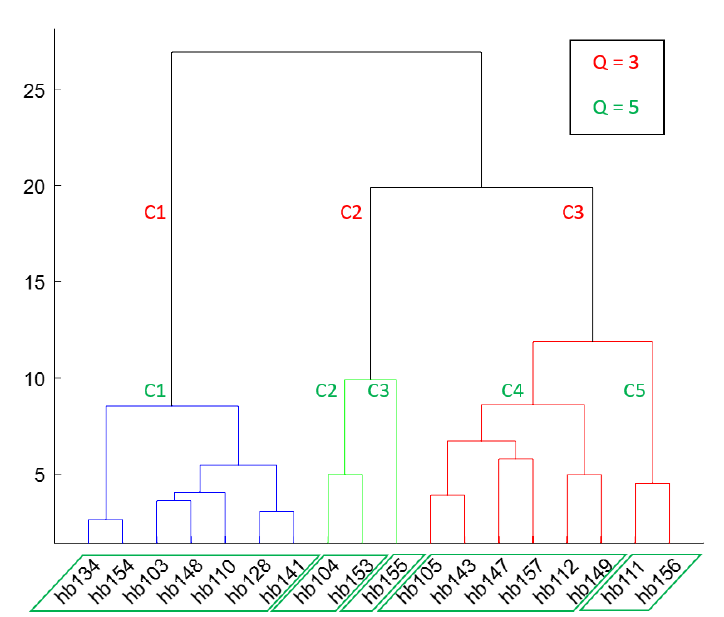
Figure 6. Dendrogram of the agglomerative hierarchical clustering for the suburban environment on the weekday. Clustering solutions for Q = 3 (in red) and Q = 5 (in green) are also